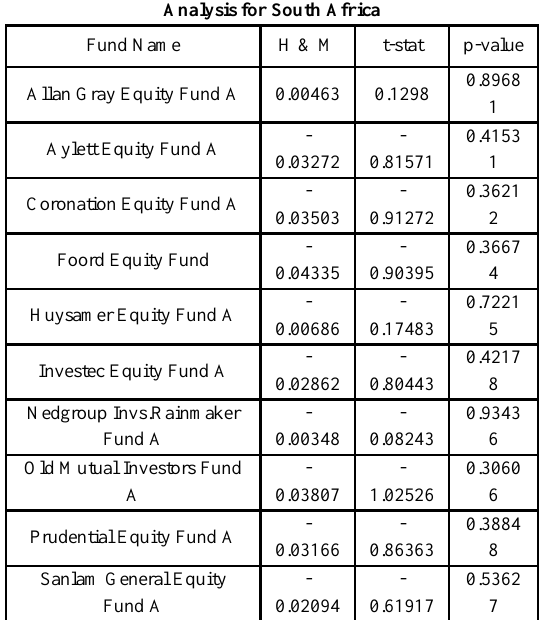
Table 7. Results of the Henriksson & Merton